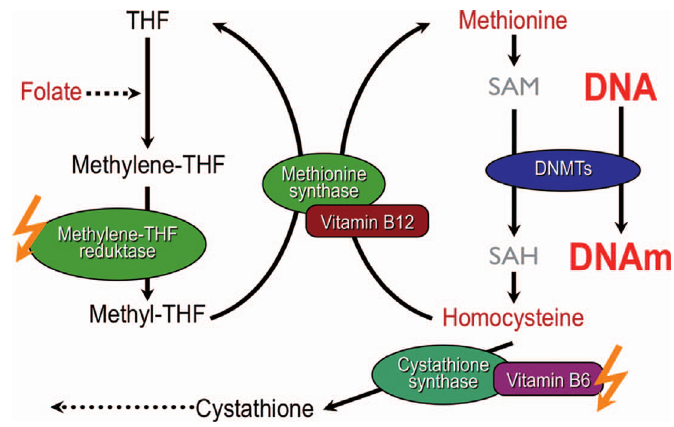
Figure 1 The THF/folate cycle regenerates methionine, which is necessary for methylation of the cytosines to 5-methylcytosine. The methyl group of SAM is transferred to the cytosines of the DNA yielding methylated DNA (DNAm). The biochemical reaction is catalyzed by DNMTs leaving SAH. SAH is regenerated by the folate metabolic pathway. The pathway depends on folate, vitamin B6 and B12. Depletion of the vitamins, mutations of methylene-THF reductase, or cystathione synthase could result in an increased homocysteine serum level and reduced availability of SAM. SAH, S-adenosylhomocysteine; SAM, S-adenosylmethionine; DNAm, methylated DNA; THF,